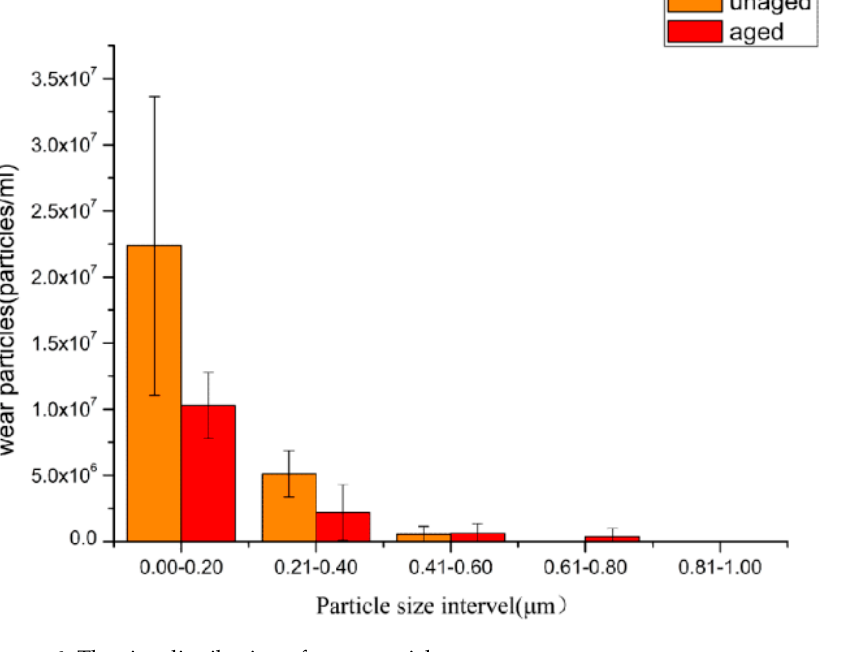
Figure 6. The size distribution of wear particles.